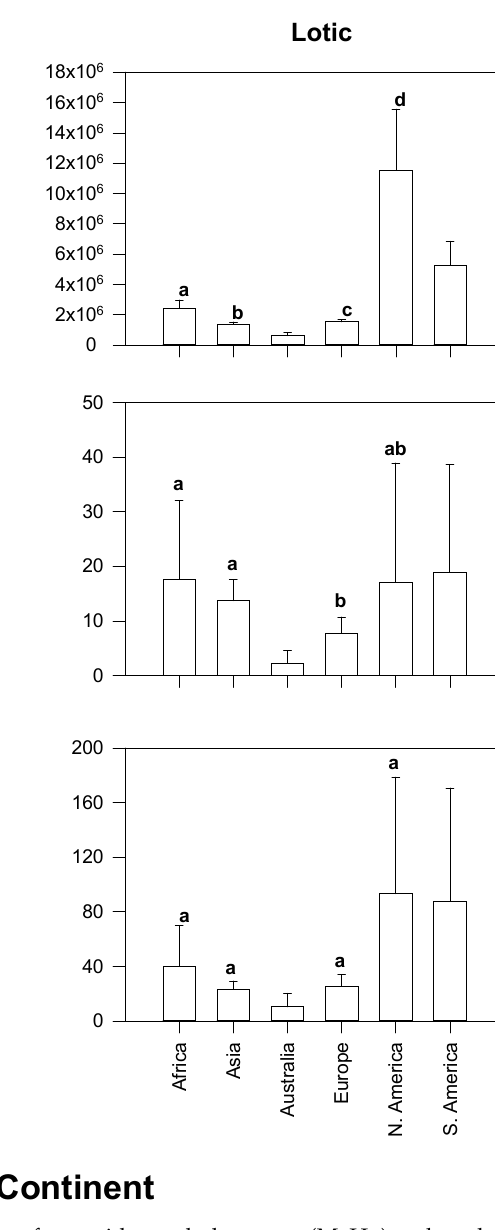
Figure 3. Estimate ( ± SD) of physiologically important fatty acids, methylmercury (MeHg) and total mercury (Hg) calculated for each continent. The letters depict results from Medcalc ® comparison of means calculator within each continent, where values with the same letters depict no significant difference between the export values. Note that only continents were emergence data are available are statistically compared.